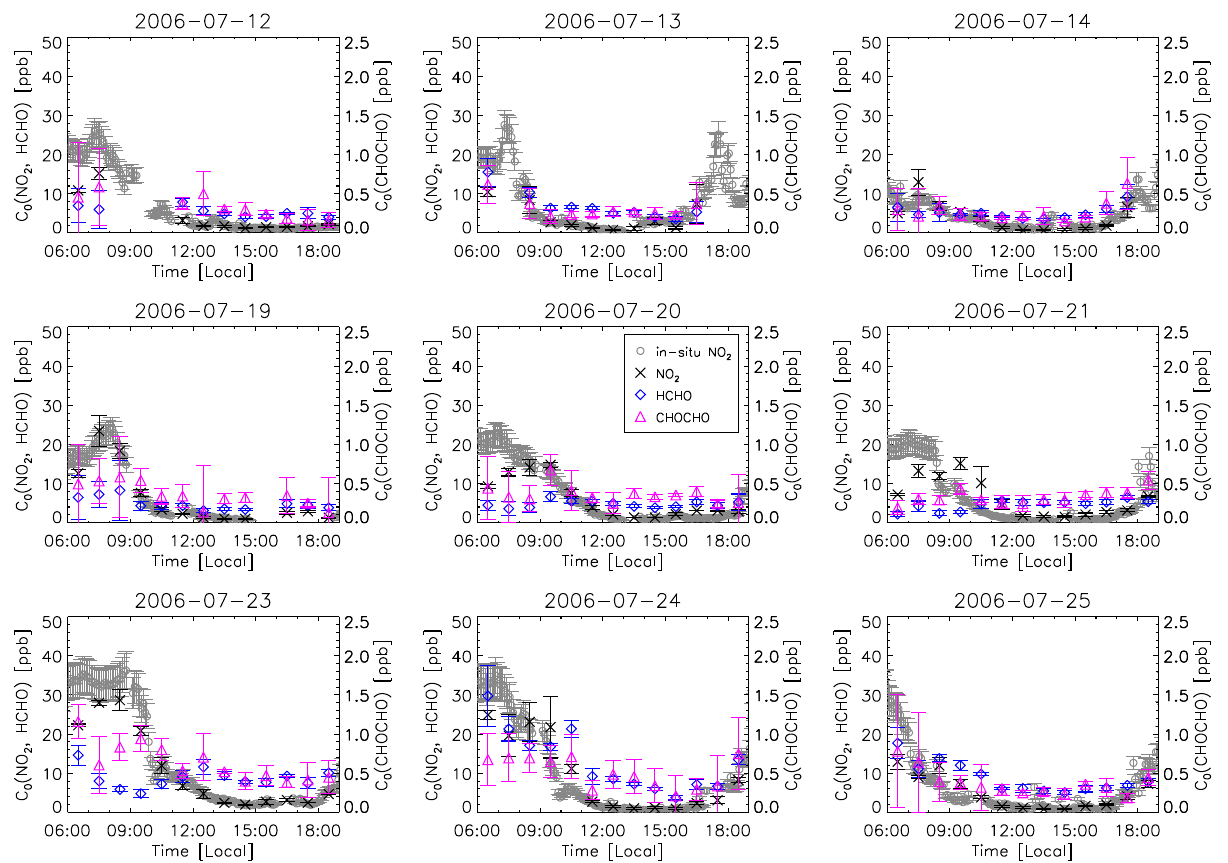
Fig. 7. Time series of NO 2 (black cross), HCHO (blue diamond), and CHOCHO (pink triangle) mixing ratios near the ground surface derived from the MAX-DOAS measurements, and NO 2 mixing ratios measured by in-situ chemiluminescence instrument (grey circle) on the 9 cloud-free days during the PRIDE-PRD2006